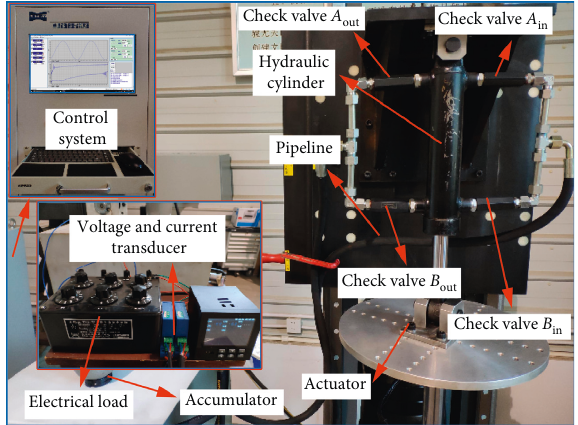
Figure 11: The HERSA test